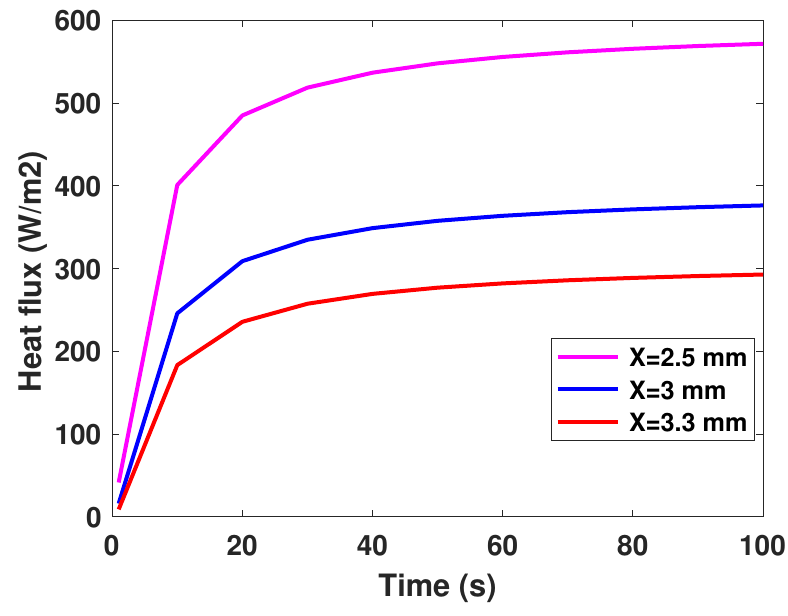
Figure 4. Model-based flux